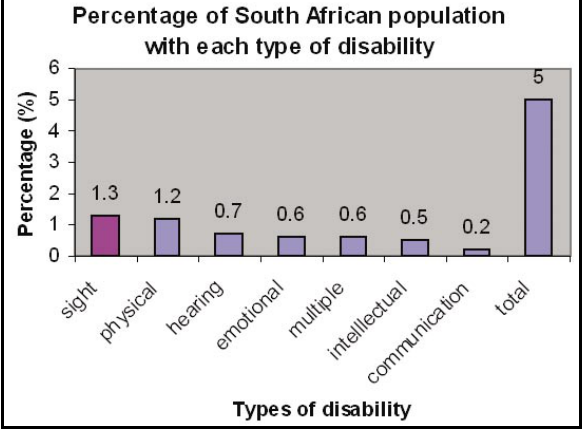
Figure 1 . Data (adapted from figure 15, reference number 13) obtained from statistics released by Statistics South Africa (2001) indicated that 2 255 982 or five percent of the total South African population were reported to have a disability preventing full participation in life activities, such as in the educational, social or work spheres. Visually impaired persons accounted for 1.3% or 577 096 persons, making up the largest disability type in the